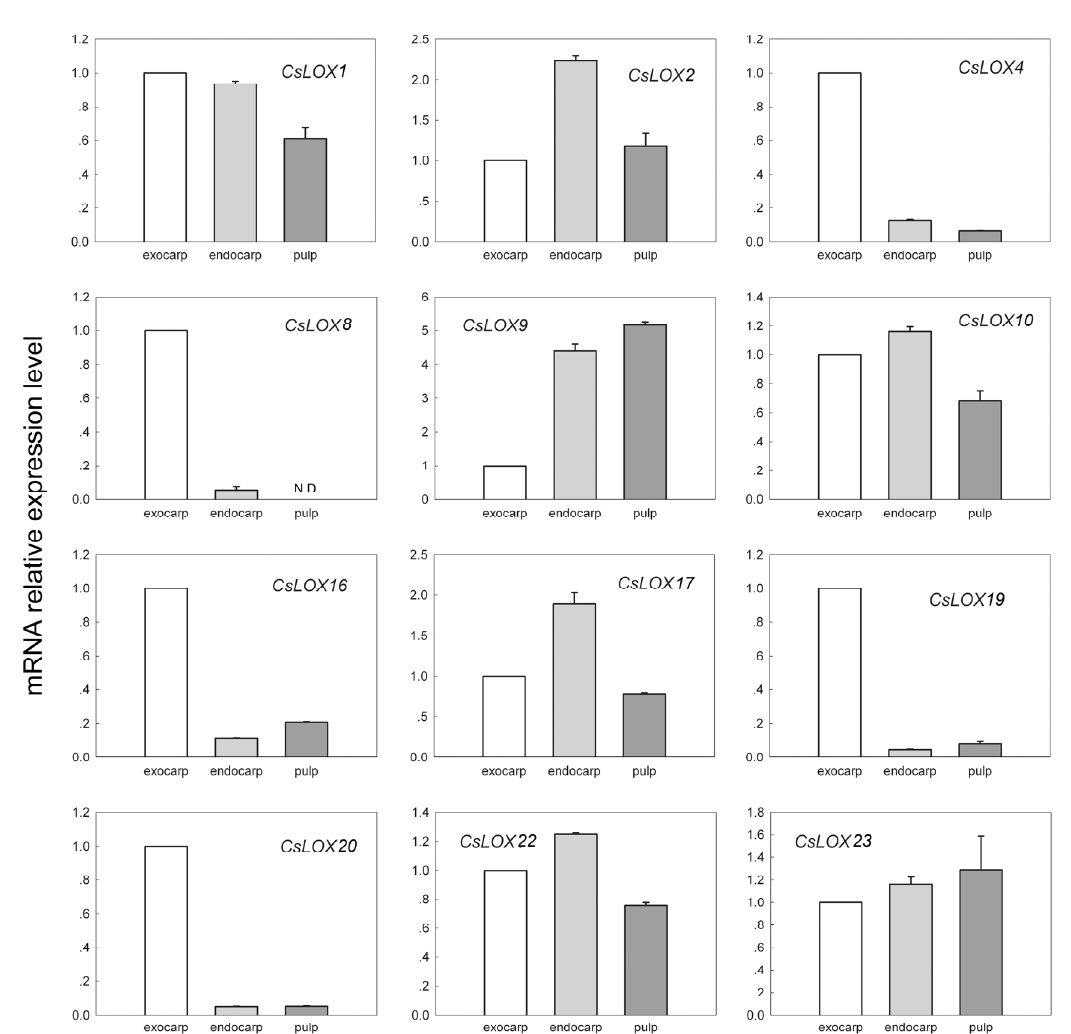
Figure 3. The distribution of identified 12 fruit LOX gene transcripts in three fruit fractions: exocarp, endocarp and pulp. The expression profiles of 12 CsLOX genes were analyzed by using Quantitative Real-time PCR in exocarp, endocarp and pulp of cucumber ( Cucumis sativus ) cv Line 9930 (a cultivar of northern China) fruits on 5 DAA. Data represent the means ± SD of three biological replicates. The expression of all the genes was normalized with reference to the expression of CsUBQ gene. N.D. represents no